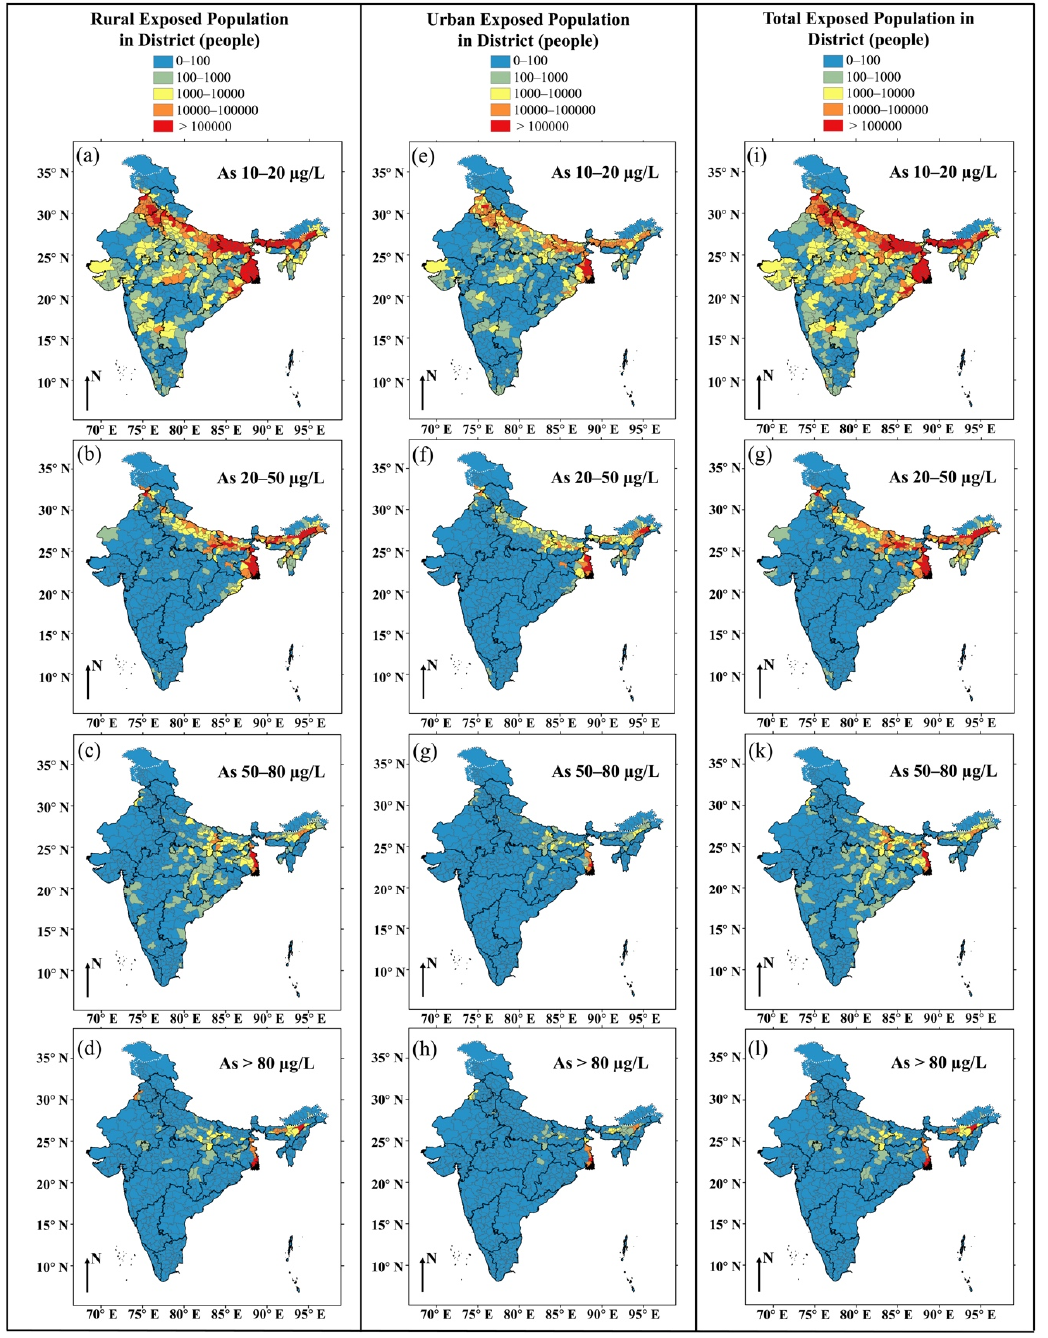
Figure 4. Maps of modelled district-wise population exposure to groundwater arsenic in specific concentration ranges and based on exposure model 1 (see text). District-wise rural ( a – d ), urban ( e – h ), and total ( i – l ) population exposed to arsenic concentration ranges of 10 to 20 μg/L, 20 to 50 μg/L, 50 to 80 μg/L, and >80 μg/L by drinking groundwater.